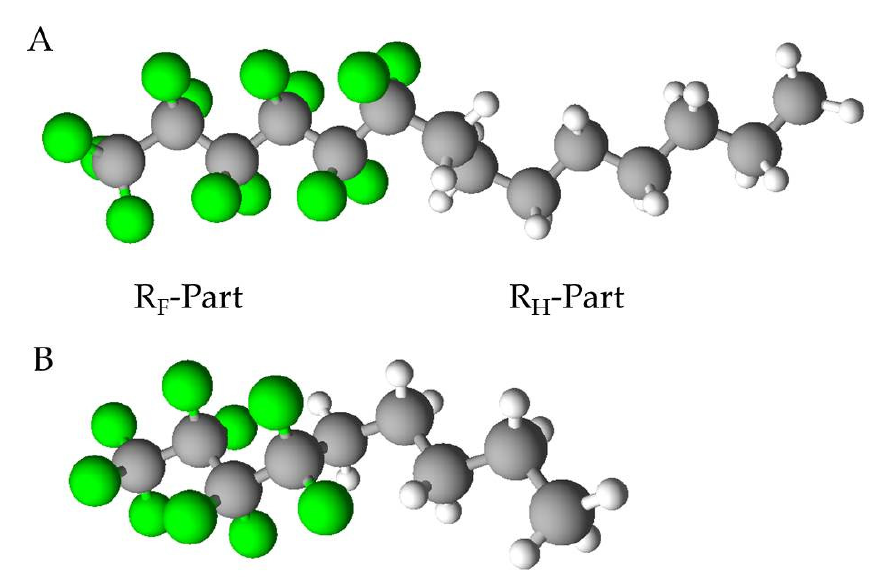
Figure 1. ( A ) Perfluorohexyloctane (F6H8) and ( B ) perfluorobutylpentane (F4H5) as example molecules for linear SFAs; R F -Part is the fluorinated part (green atoms), the R H -Part the hydrogenated (white) of the carbon chain (grey).